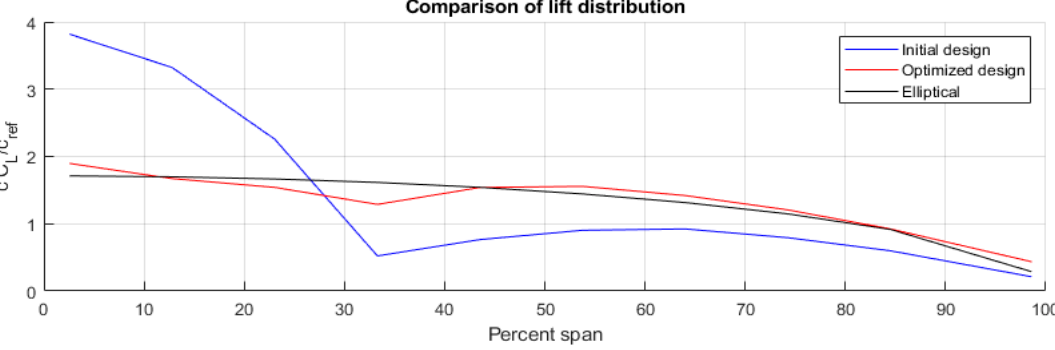
Figure 12. Comparison of lift distribution between initial and optimized designs.